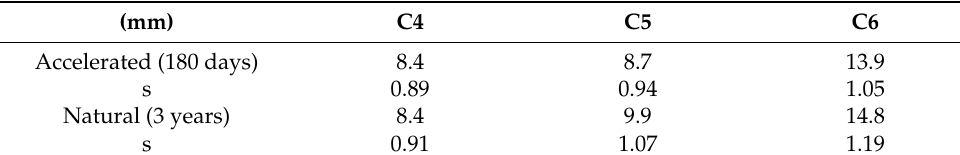
Table 15. Carbonation depth of C30/37 strength class mixtures.